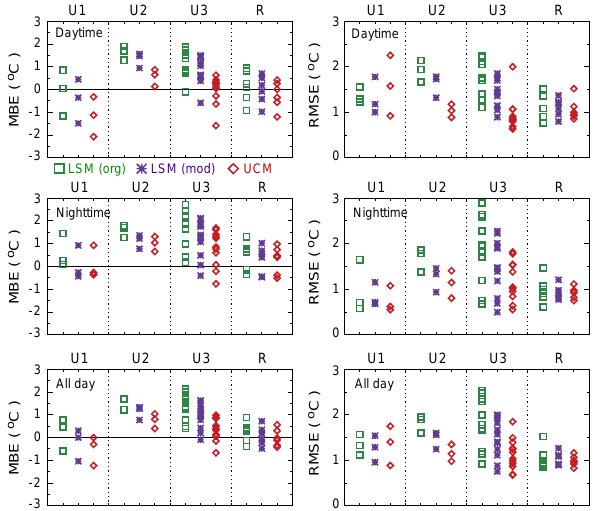
Fig. 5. Mean bias errors (MBEs) (left panels) and root mean squared errors (RMSEs) (right panels) from statistical compari- son of 2-m air temperature at 24 surface sites during the day- time (09:00–17:00LT), nighttime (01:00–05:00LT and 21:00– 24:00LT), and all day. U1, U2, U3, and R represent the commer- cial/industrial area, the high-density residential area, and the low- density residential area, and the natural surfaces, respectively.